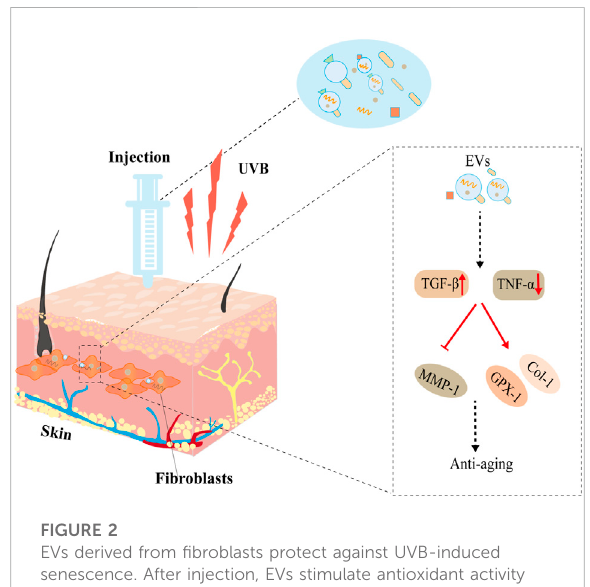
FIGURE 2 EVs derived from fi broblasts protect against UVB-induced senescence. After injection, EVs stimulate antioxidant activity (GPX-1), promote extracellular matrix reconstruction (TGF- β , Col- 1, MMP1), improve cellular necrosis (TNF- α ), and thus protect against UVB-induced